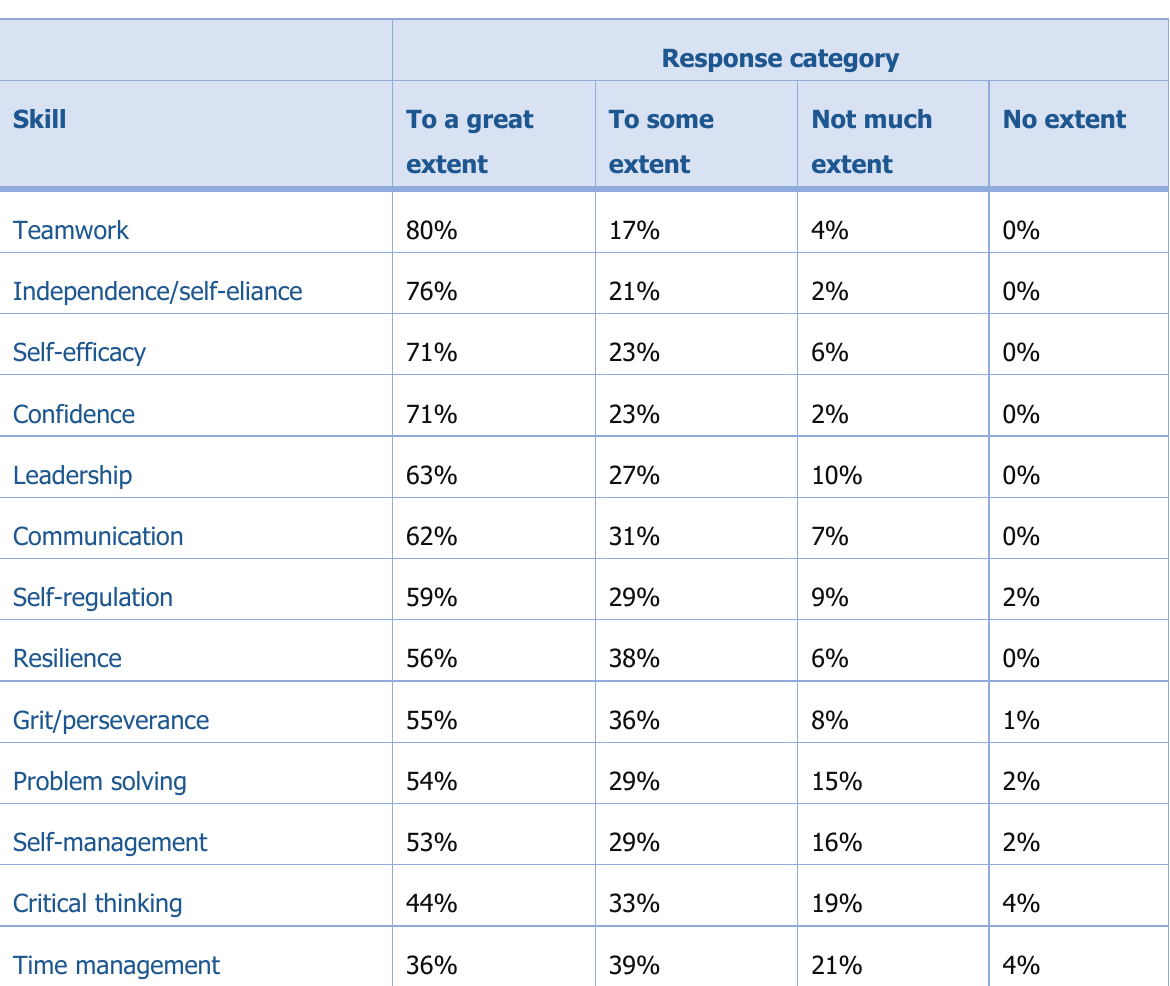
Table 2. College Readiness Skills Reported in Percentage for Men: Highest Reported to Lowest Reported (n =